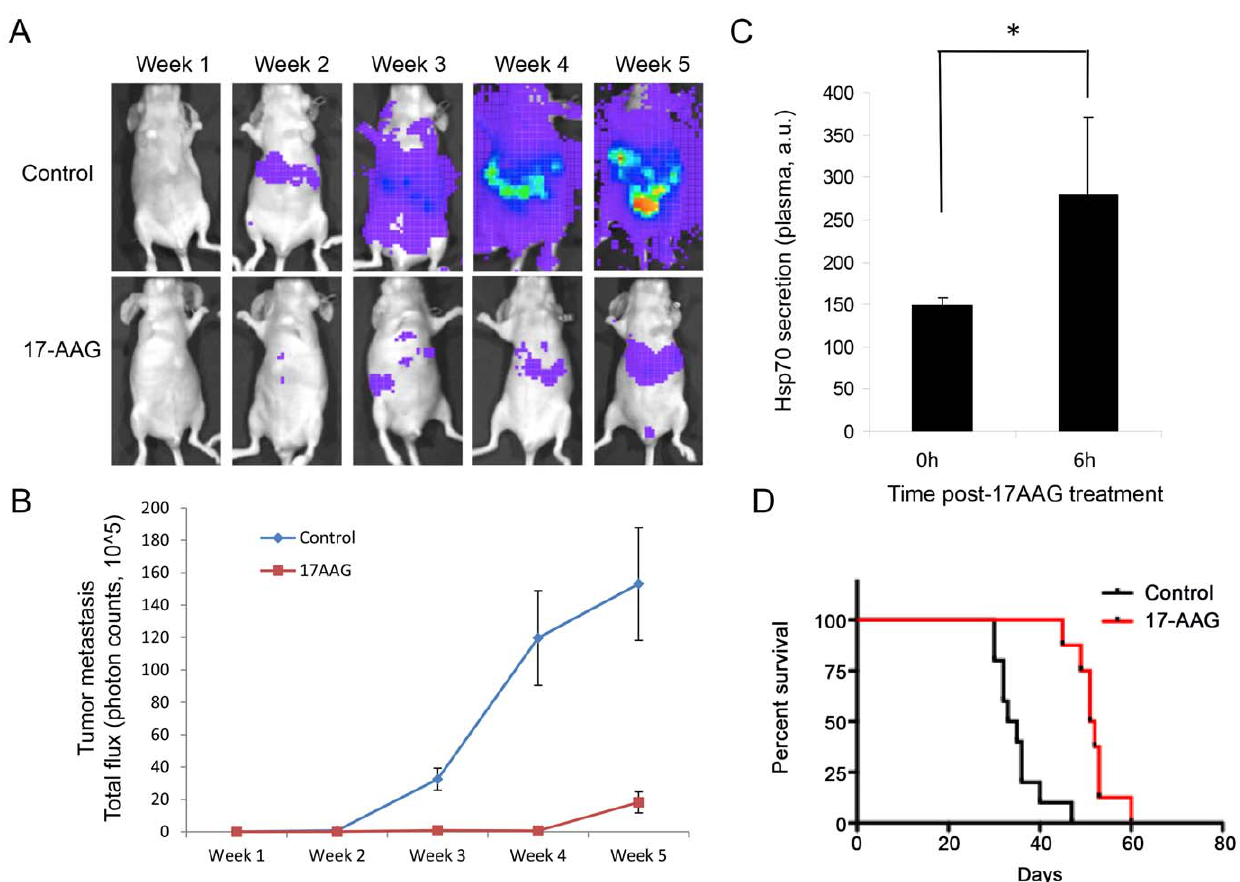
Figure 4. 17-AAG inhibits tumor metastasis in a luciferase metastatic pheochromocytoma model. A) Efficacy of 17-AAG in an MTT-luc experimental (tail vein) metastasis model. Representative images of animals (n=6) treated three times a week with 17-AAG over a period of 5 weeks and a control group treated with vehicle alone. B) Quantification of metastatic tumor growth as determined by luciferase measurement in an IVIS instrument. Data are plotted as mean photon counts (total flux) from regions of interest (ROI). Error bars represent standard deviations. C) 17-AAG increases Hsp70 plasma levels in vivo (p=0.035). D) Kaplan-Meier survival analysis: outcome as survival time was graphed and analyzed for statistical significance using GraphPad; control (vehicle alone; black line) and 17-AAG treated animal (red line) are represented as a function of percent survival. Using a log-rank (Mantel-Cox) test the two groups were statistically different at p , 0.0001.